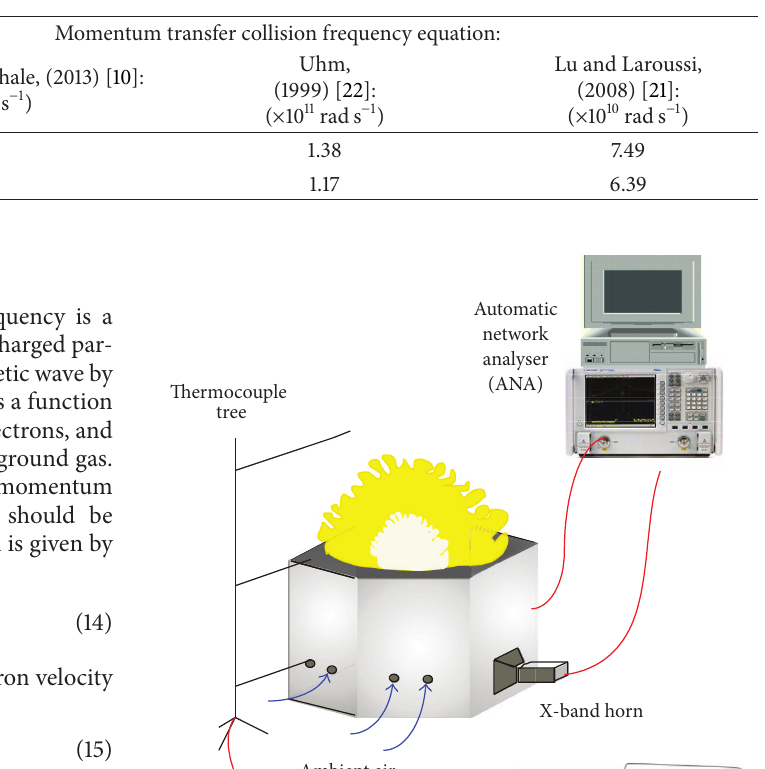
Table 1: Momentum transfer collision frequency from relation in the literature.